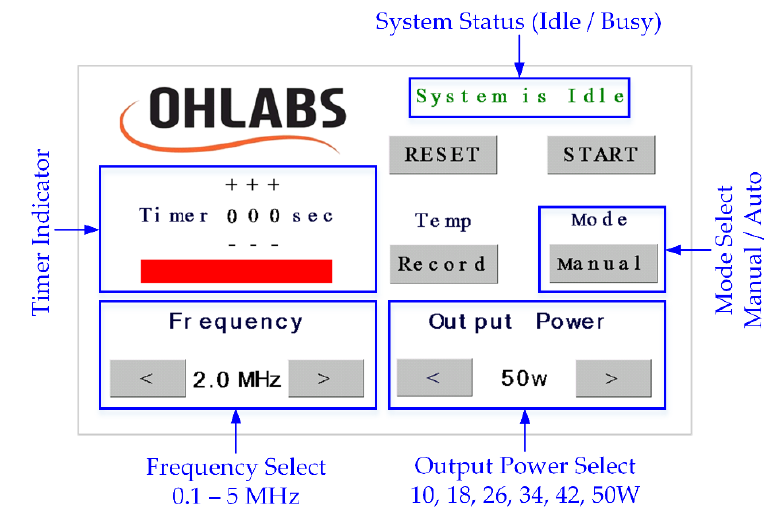
Figure 2. HIFU system touch screen interface.